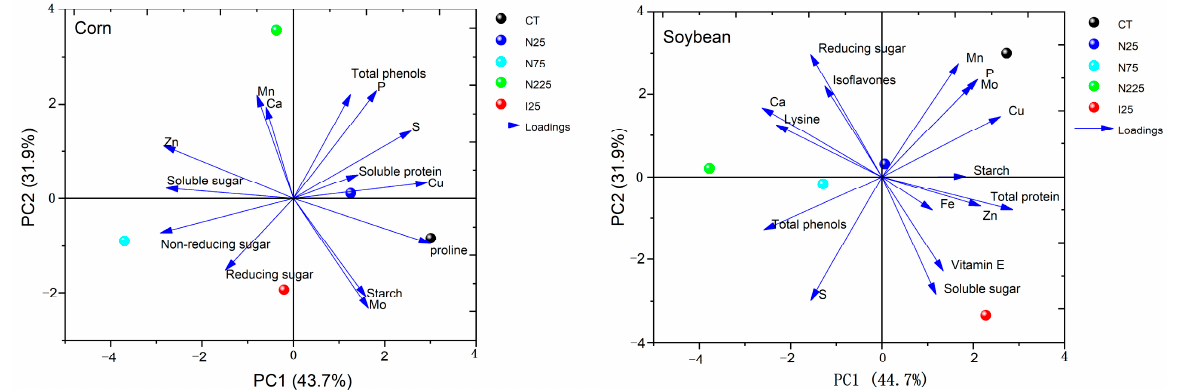
Figure 6. Principal component analysis plot of element content and nutritional quality indexes of maize and soybean plants among different treatments.